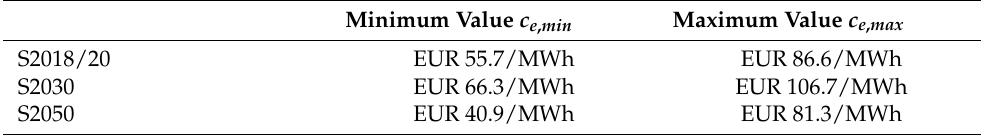
Table 10. Specific electricity cost minimum and maximum values for the different scenarios, set by